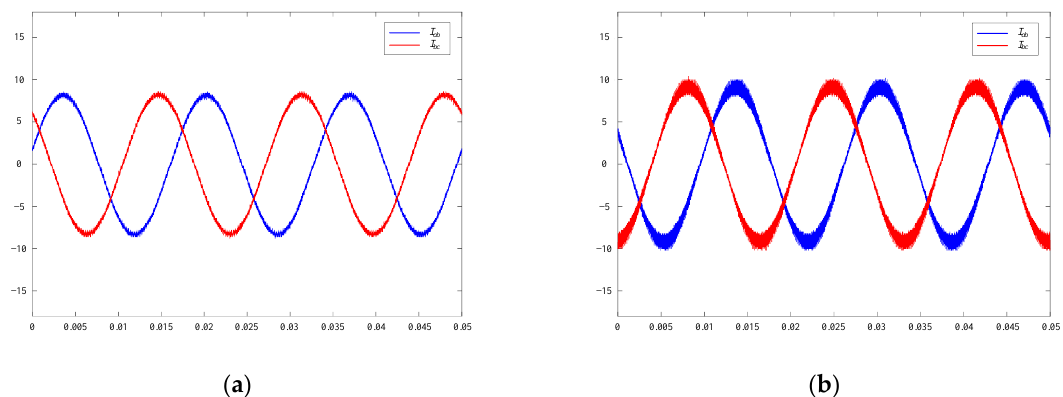
Figure 14. Waveforms of grid current i g on the novel hybrid real-time simulator. ( a ) L g = 1 mH; ( b ) L g = 0 mH.